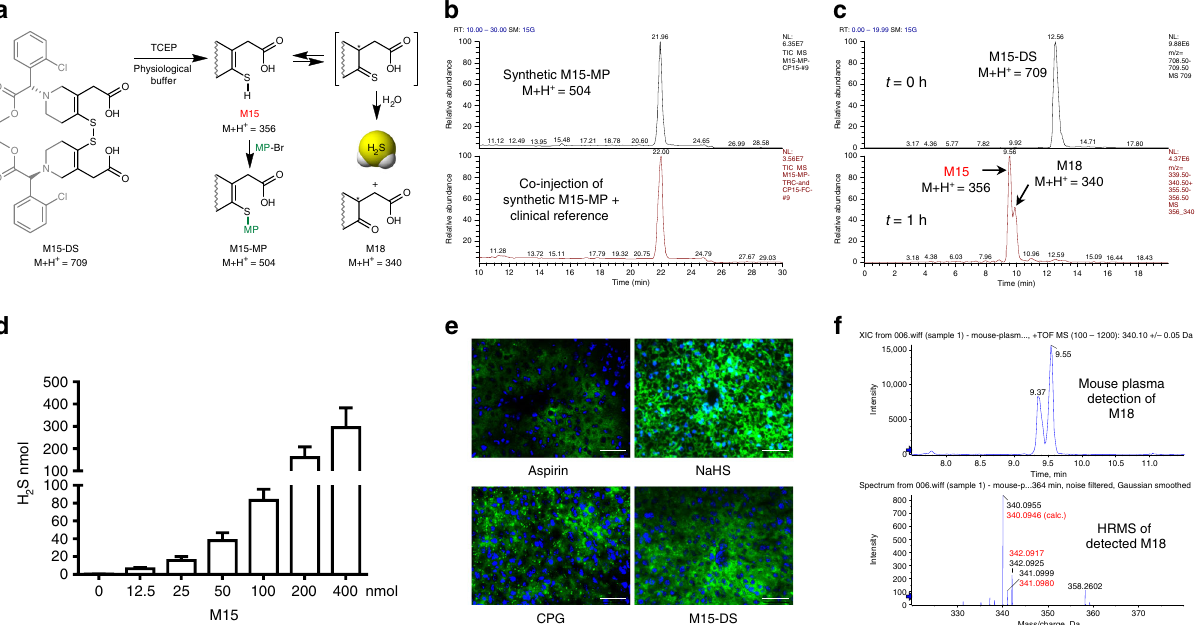
Fig. 3 Human circulating metabolite M15 is a H 2 S donor. a Reductive cleavage of synthetic M15-DS in vitro to M15 followed by chemical derivatization or spontaneous degradation. b Synthetic M15-MP shows to be identical to clinical reference. c M15 conversion to desulfurized metabolite M18 in vitro; d stoichiometric H 2 S release from M15 detected by methylene blue method in vitro (data is displayed as means ± S.D., n = 4). e In vivo mouse studies of H 2 S release from CPG and M15-DS using fl uorescent imaging probe Mito-HS ( n = 4). Scale bars are 50 μ m. f Detection of H 2 S-released metabolite M18 in mouse plasma from in vivo